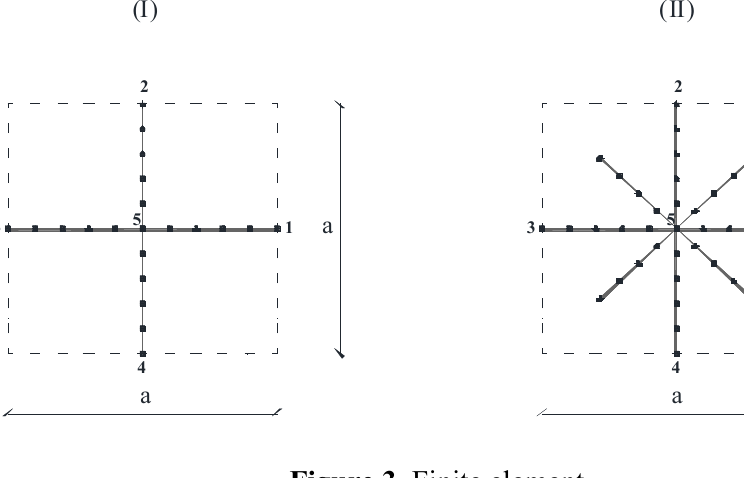
Figure 3. Finite